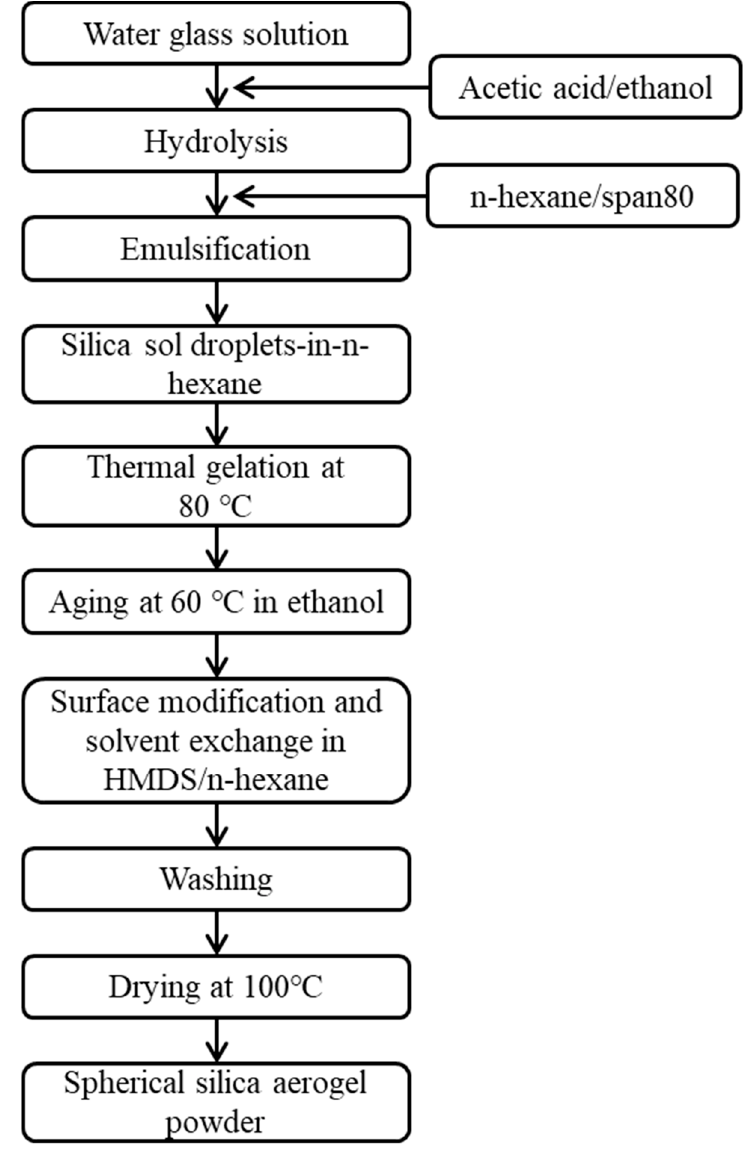
Figure 1. Experimental flow chart for synthesis of spherical silica aerogel